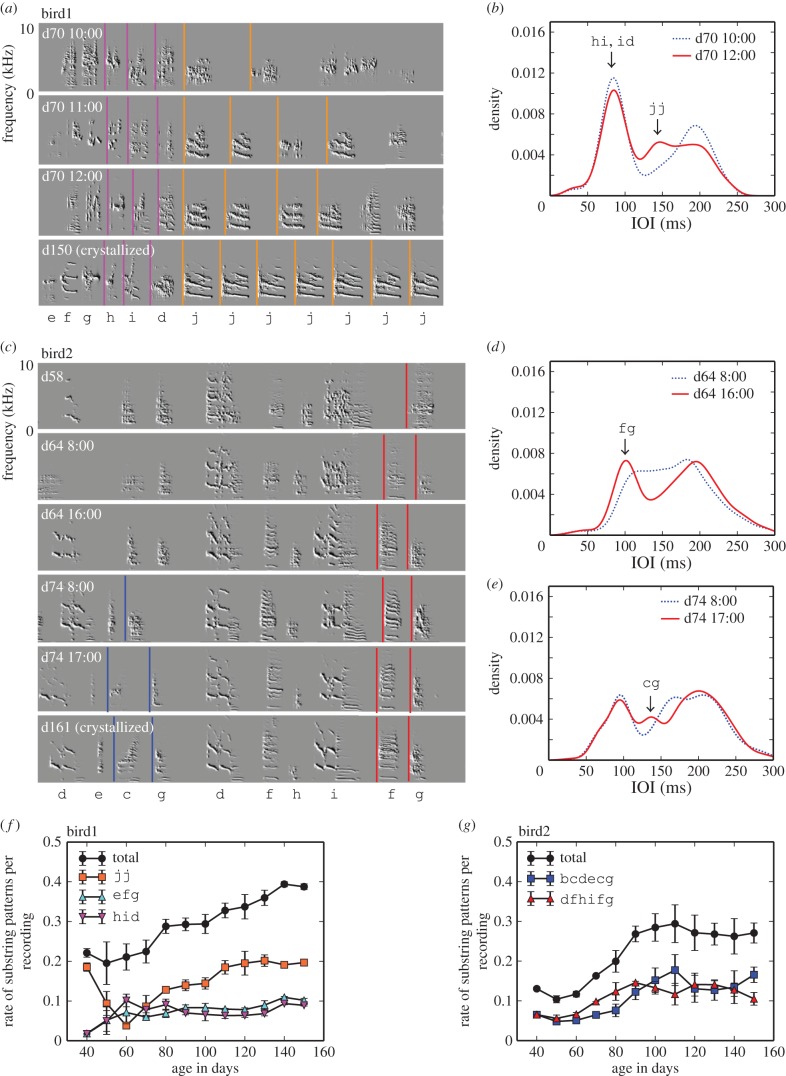
Development of substring patterns. (a) Sound spectrograms of developmental songs and (b) hourly changes of IOI distribution in bird1 (N = 6740 for 10 : 00, N = 3309 for 12 : 00). (c) Sound spectrograms of developmental songs and (d,e) hourly changes of IOI distributions in bird2 at day 64 (N = 4875 for 8 : 00, N = 1300 for 16 : 00) and day 74 (N = 3031 for 8 : 00, N = 3182 for 17 : 00). In (a) and (c), letters denote note types, coloured vertical lines correspond to the IOIs for particular transitions with self-repetitions or chunks. Use rate of substring patterns per recording at different days for bird1 (f) and bird2 (g) (mean ± s.d.).